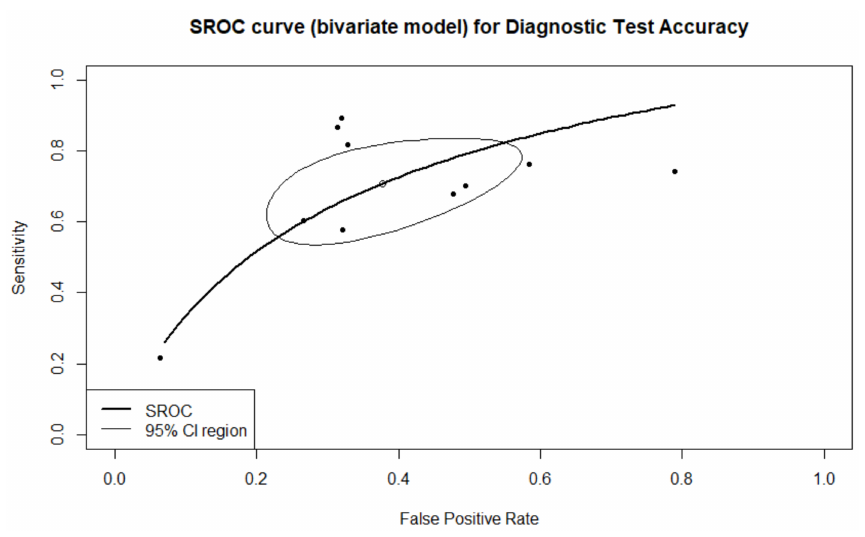
Figure 5. Prediction of pregnancy